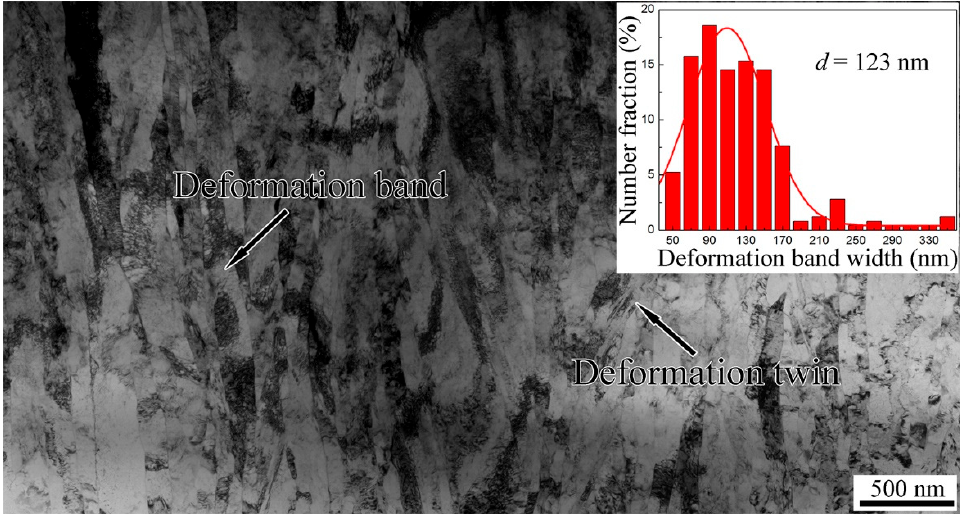
Figure 4. A longitudinal cross-section TEM observation of the aged Cu-0.4Cr-0.4Hf-S2. The inset shows the distribution of the deformation band width in the aged Cu-0.4Cr-0.4Hf-S2.